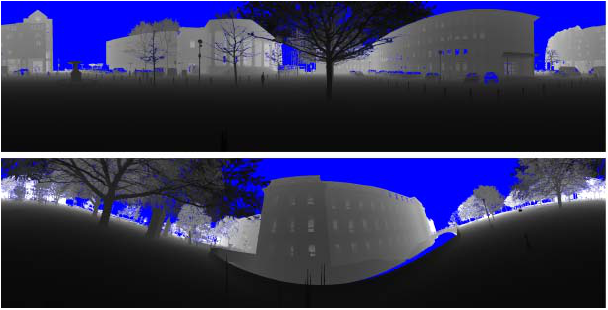
Figure 3. Range data—grayscale values represent ranges from the scanner.